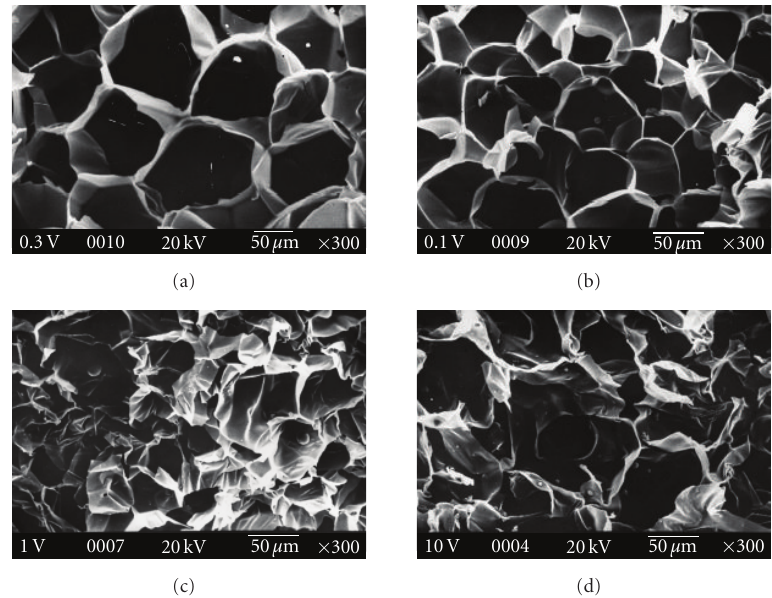
Figure 3: Scanning electron micrograph of microspheres incorporated gelatin sca ff olds. (a) Pure gelatin sca ff old, (b) 0.1% w/w PLGA microsphere incorporated sca ff old, (c) 1% w/w PLGA microsphere incorporated sca ff old, and (d) 10%w/w PLGA microsphere incorporated sca ff